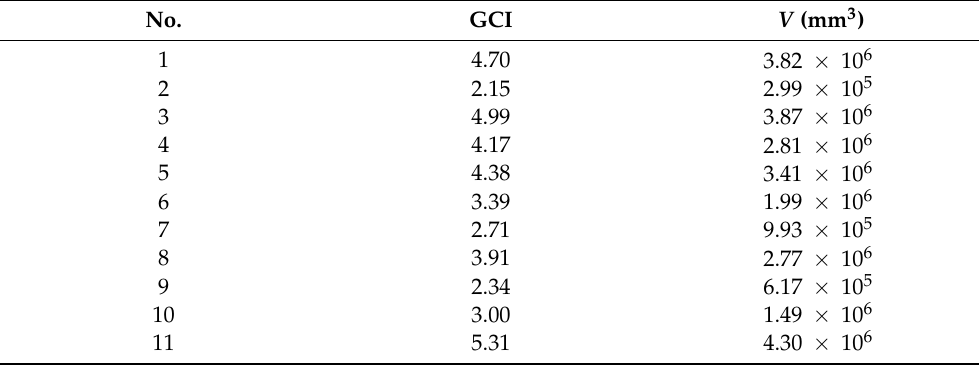
Table 4. Optimized V and GCI of the